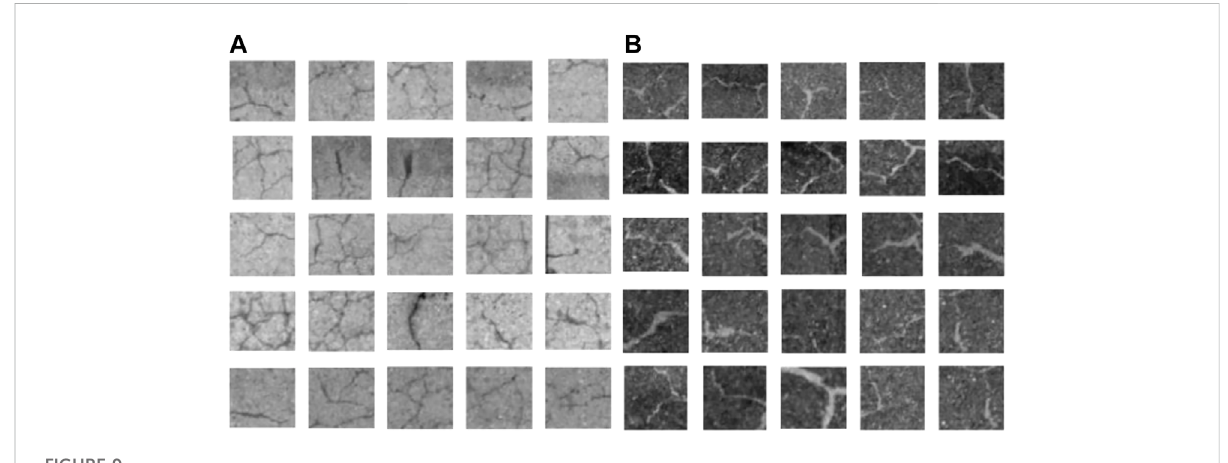
FIGURE 9 Images before color tone correction. (A) Crack. (B) Free